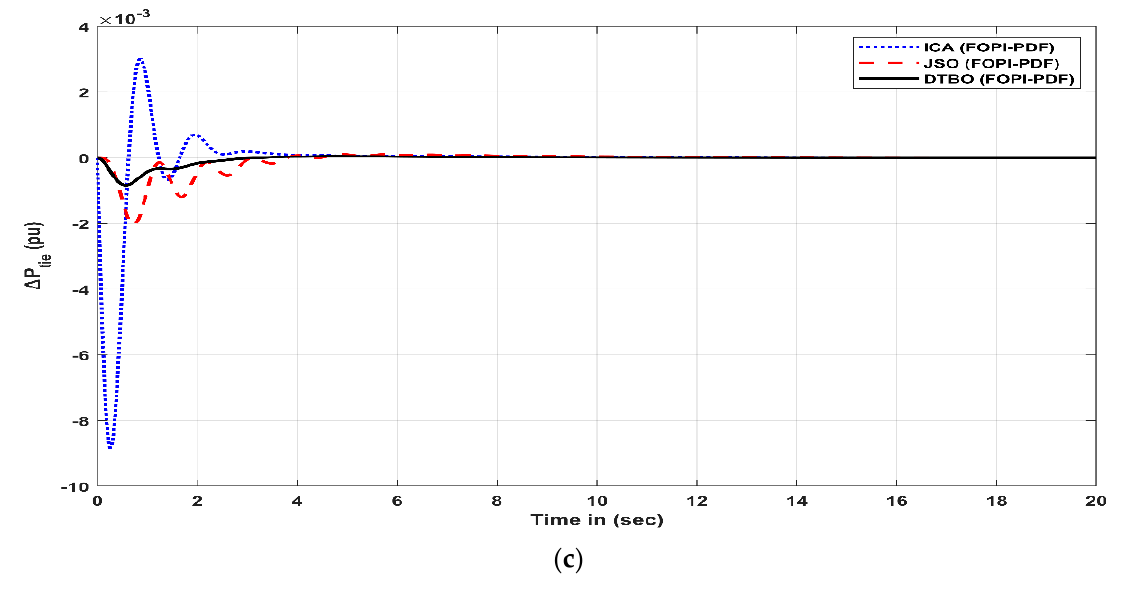
Figure 8. Dynamic response of the power system for case-1 ( a ) ∆ F 1 ( b ) ∆ F 2 ( c ) ∆ P tie . Table 2. Transient results for PS considering Case-1.